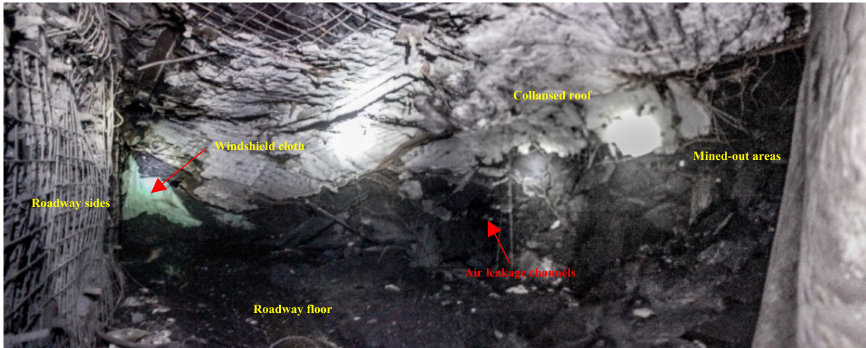
Figure 10. Collapse zone of the lower end of the working